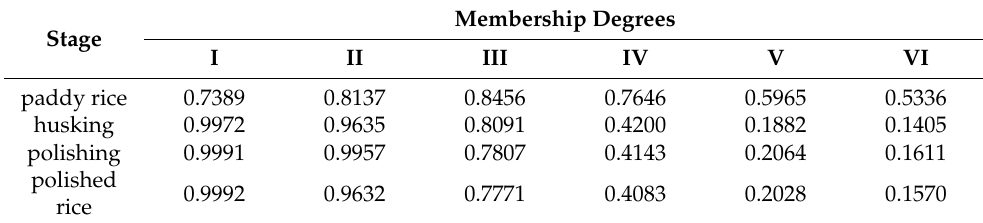
Table 8. Membership degrees for each level of the rice processing chain.